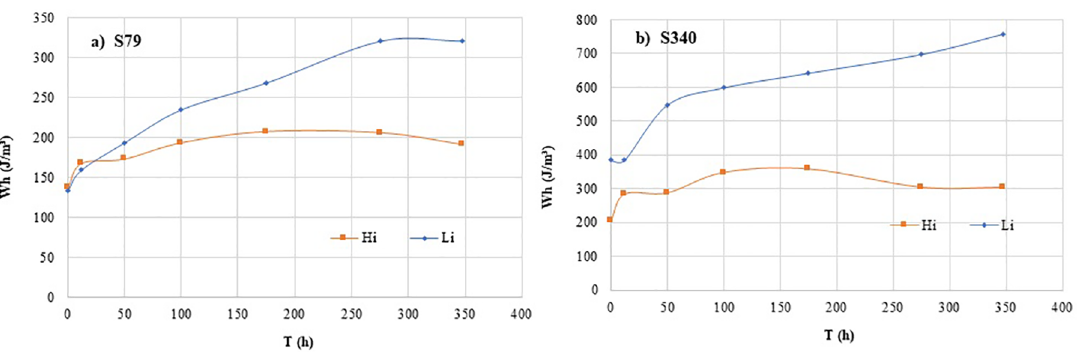
Figure 5. Hysteresis loss (1.5T) subdivision using the induction at maximum permeability as the limit between the low-induction and the high-induction regions